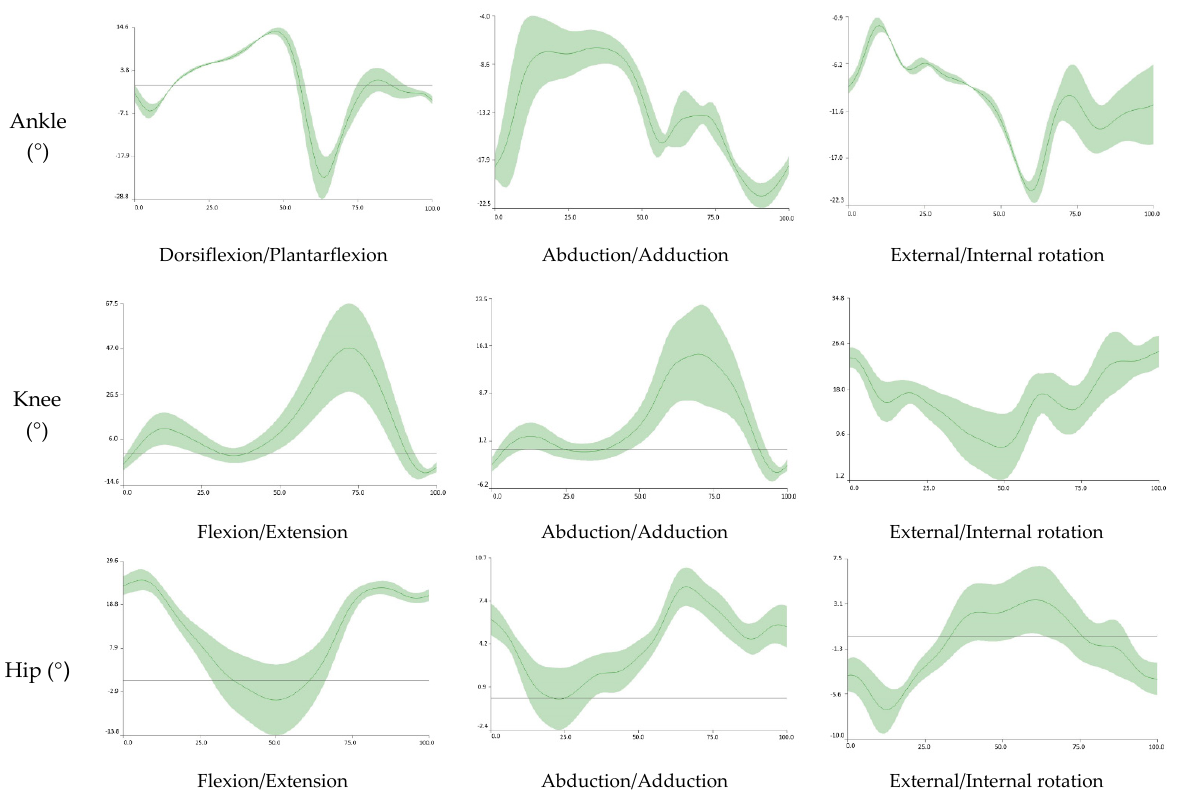
Figure 2. Kinematics of various of FF lower limb joints during gait. The Center of Mass variation over gait is illustrated in Figures 3 and 4 (NF and FF subjects respectively).